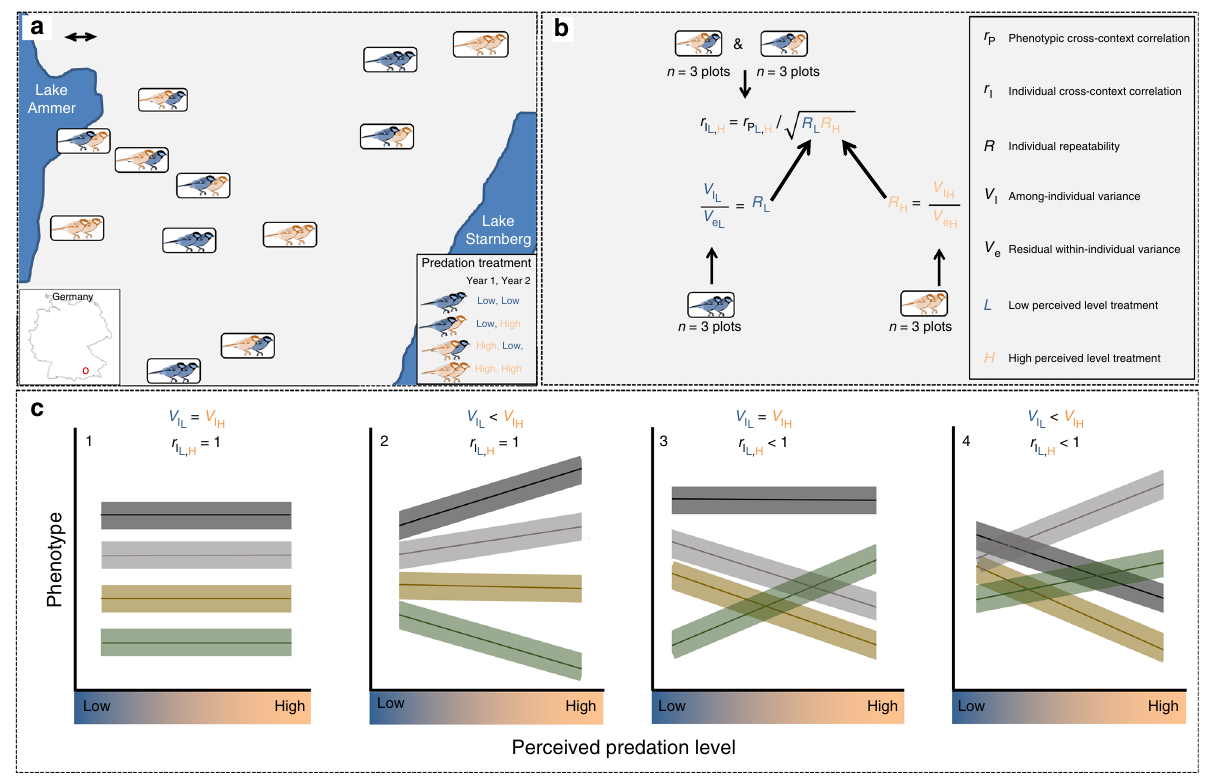
Fig. 1 Experimental design. a Study area of 12 nest box plots (rectangular boxes) situated in Southern Germany. Colored great tit symbols represent each plot ’ s treatment (blue: low perceived predation level (PPL): orange: high PPL) in the fi rst (left-hand bird) and second (right-hand bird) year of study. Scale bar is 1 km. b The among-individual variance ( V I ), the residual within-individual variance ( V e ), and the cross-year repeatability ( R ¼ V I V ) for timing of þ V I e breeding (and other traits) were calculable for the low-PPL and high-PPL environment since six plots received the same treatment (3 low, 3 high) across years. The phenotypic cross-context correlation ( r ) between a female ’ s timing of breeding under low versus high PPL was calculated using data from six P L ; H plots that changed treatment across years. This parameter represents an attenuated estimate of the among-individual cross-context correlation ( r ) that I L ; H our unique partial crossover study design allowed estimating (for details, see Methods). c This in turn enabled us to differentiate between four distinct scenarios describing how individual reaction norms for timing of breeding (and other traits) varied as a function of PPL (detailed in main text). Those ¼ V ≠ V scenarios differed in whether treatment-speci fi c among-individual variance was absent ( V ) versus present ( V ) and whether reaction norm I L I H I L I H ¼ 1) versus present ( r crossing was absent ( r 1). Here we illustrate possible scenarios given the assumption that mean breeding date is similar in I L ; H I L ; H < both contexts, and the variance is either the same or higher under